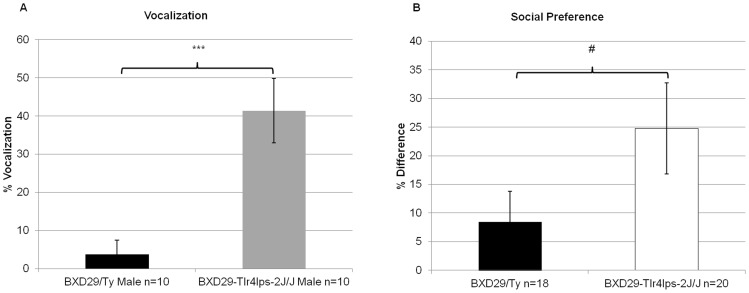
Examination of behavioral response to different social contexts in BXD29-Tlr4lps−2J/J mutant and BXD29/Ty wildtype mice.A) Analysis of male BXD29-Tlr4lps−2J/J and BXD29/Ty ultrasonic vocalization emissions when exposed to seven-day-old dirty female bedding demonstrated that male BXD29-Tlr4lps−2J/J mutant mice spent significantly more time vocalizing in response to dirty female bedding in comparison to male BXD29/Ty wildtype mice. B) Social preference data revealed a nearly significant trend that suggested BXD29-Tlr4lps−2J/J mutant mice, in general, may prefer increased social interaction with a stranger mouse in comparison to a novel inanimate object. #P = 0.1; ***P<0.001.